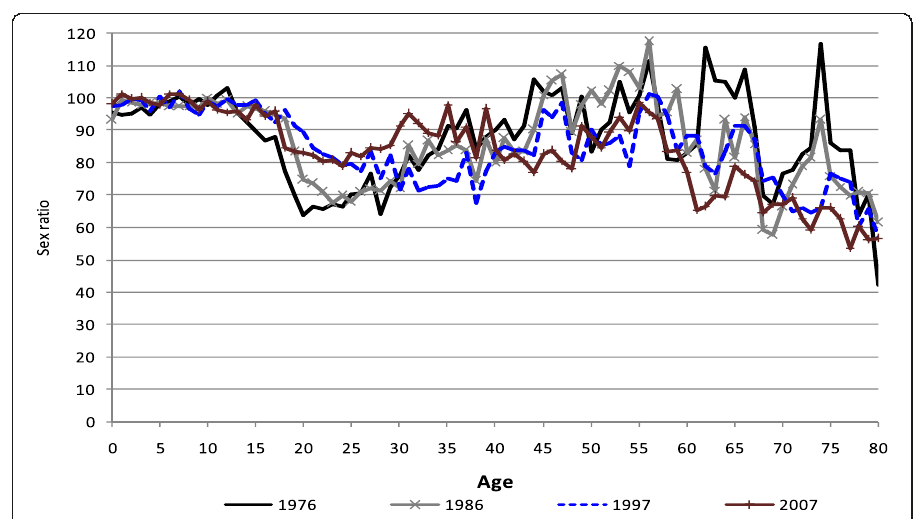
Fig. 3 Sex ratios of the population aged 0 – 80, Swaziland, 1976 – 2007 PHC. Source: published raw data from Swaziland PHC